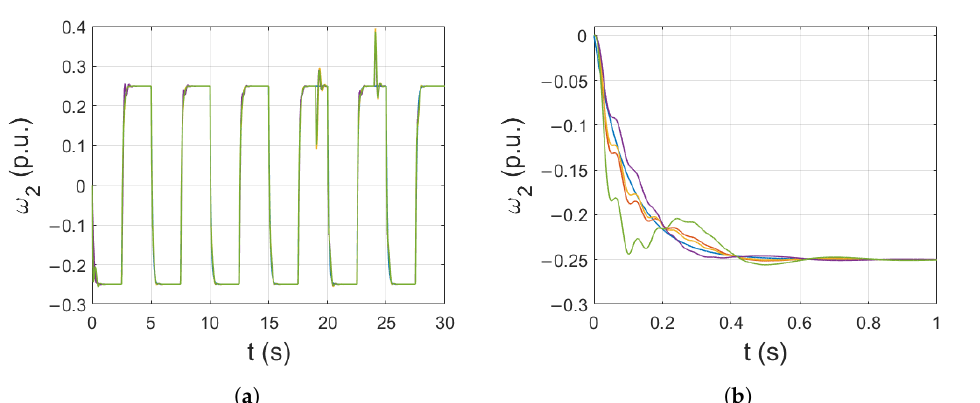
Figure 8. Influence of initial widths randomization (of radial activation functions) ( a ), close-up of the beginning of the simulation ( b ).